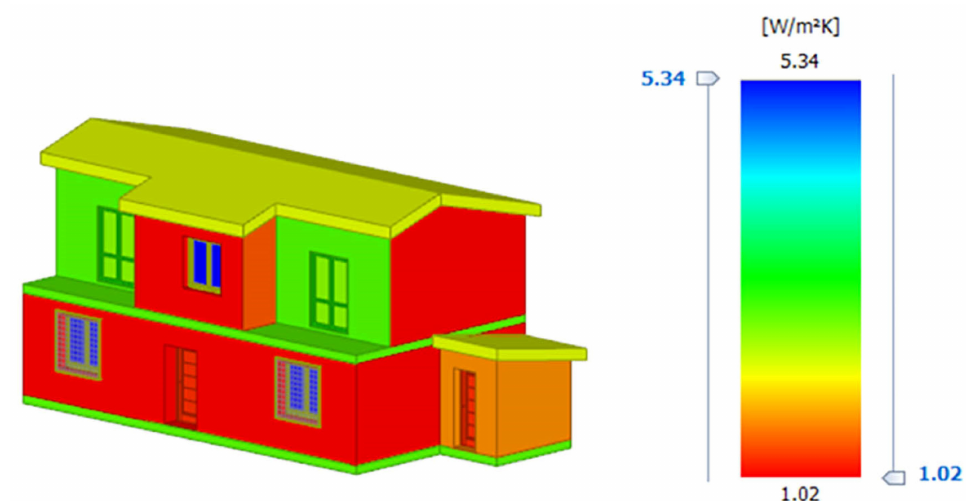
Figure 5. Demonstrator building energy model (BEM).